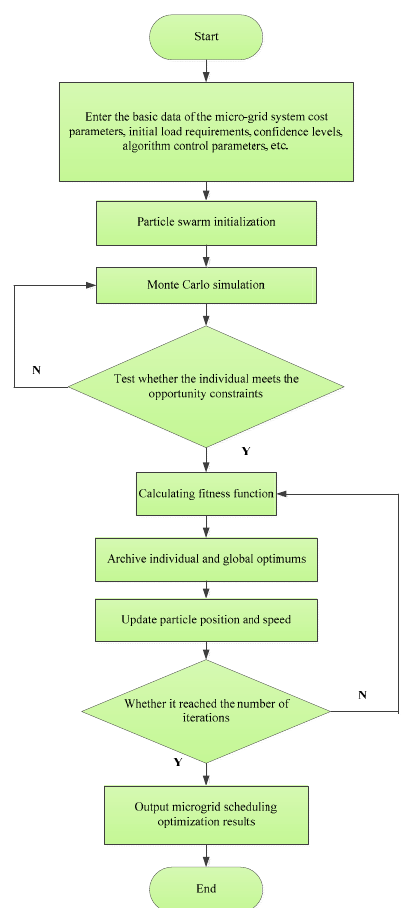
Figure 3. The flow chart of the algorithm solution.